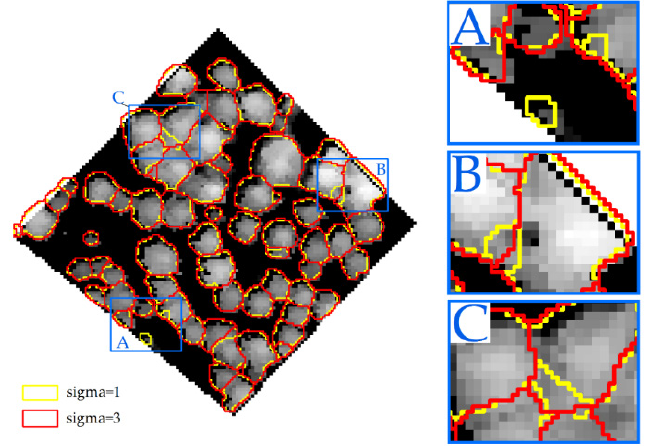
Figure 6. The sensitivity analysis of the WA in plot 6. ( A ) is the under-segmentation, ( B ) is the crown boundary details and ( C ) is a complete tree divided into two trees.